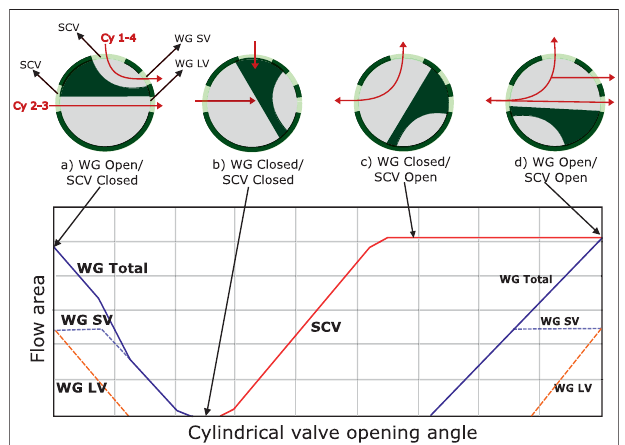
FIGURE 5 | Wastegate and SCV fl ow areas with the cylindrical valve